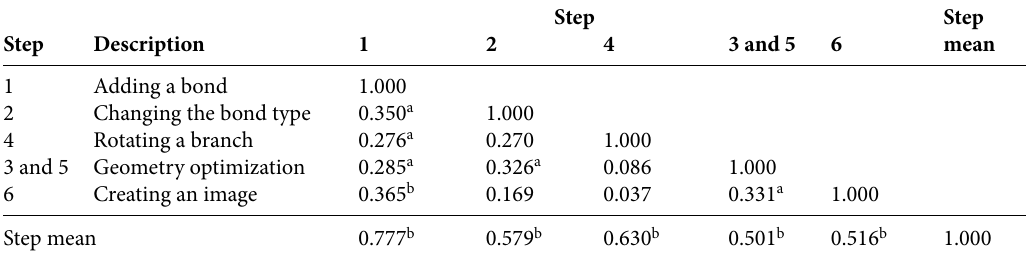
Table 12: Spearman correlations between step difficulty levels within Activity